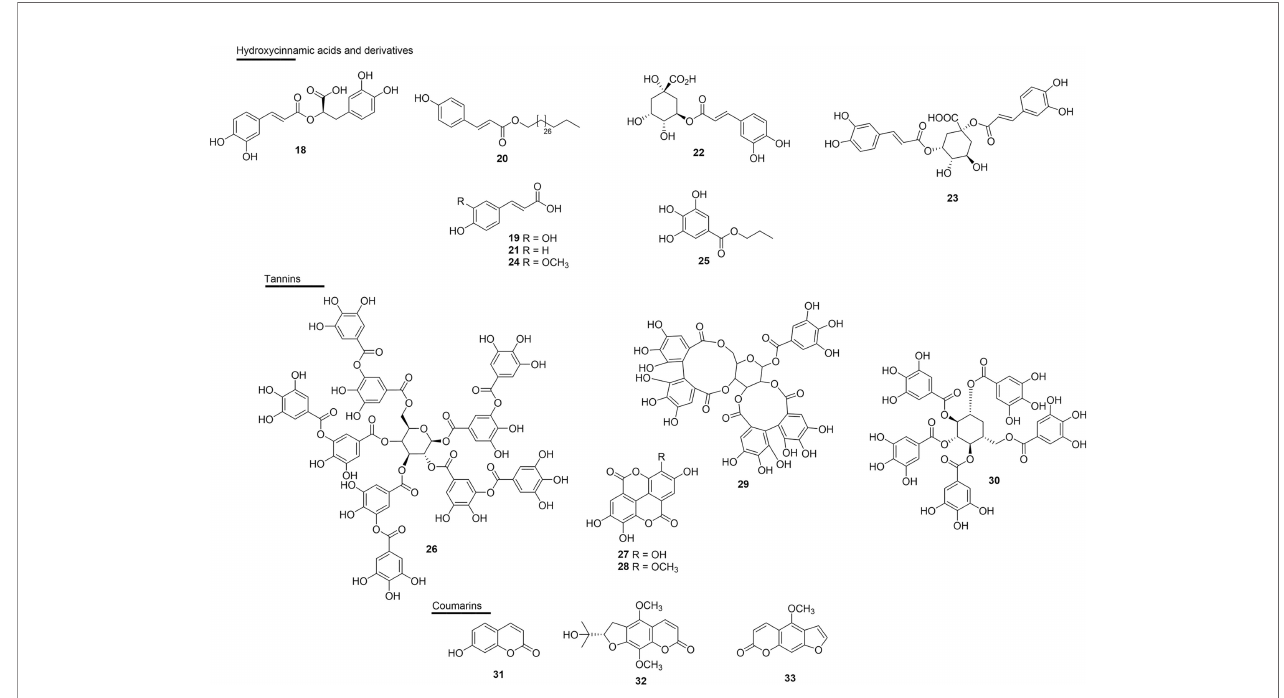
FIGURE 5 | Chemical structures of snakebite treatment compounds 18-33